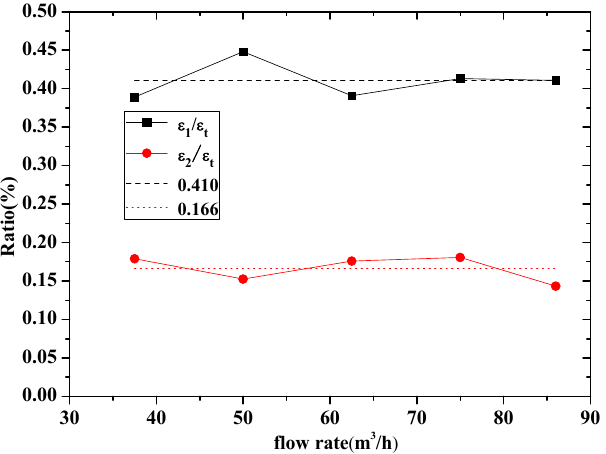
Figure 10. The acoustic energy changing curves with flow rate (2900 rpm).